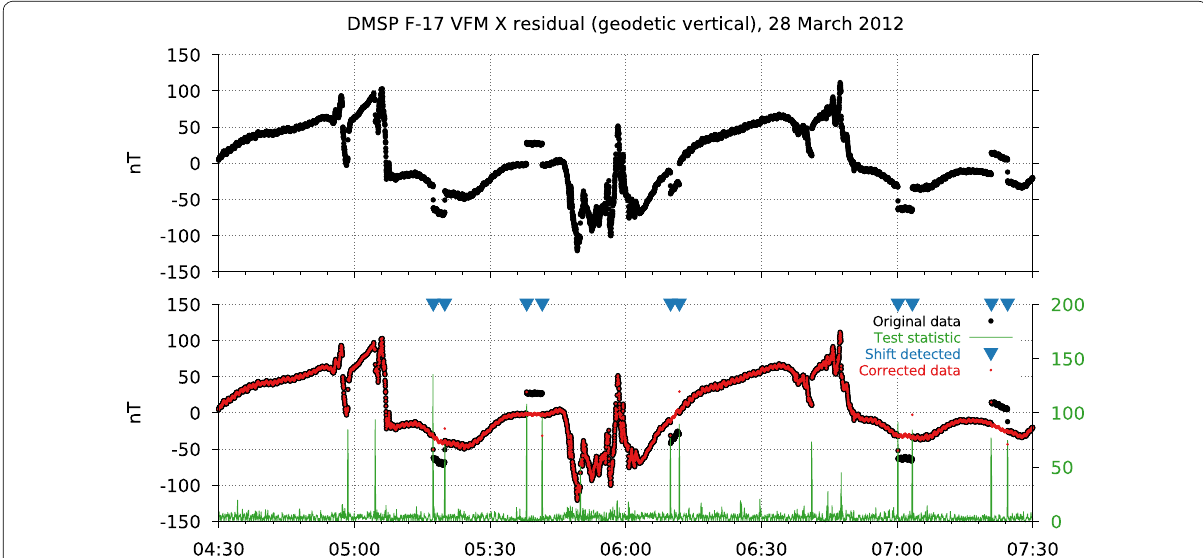
Fig. 2 Top: example X residual from DMSP F-17 in instrument frame. Bottom: test statistic (green), level shift detections (blue triangles), and corrected residual